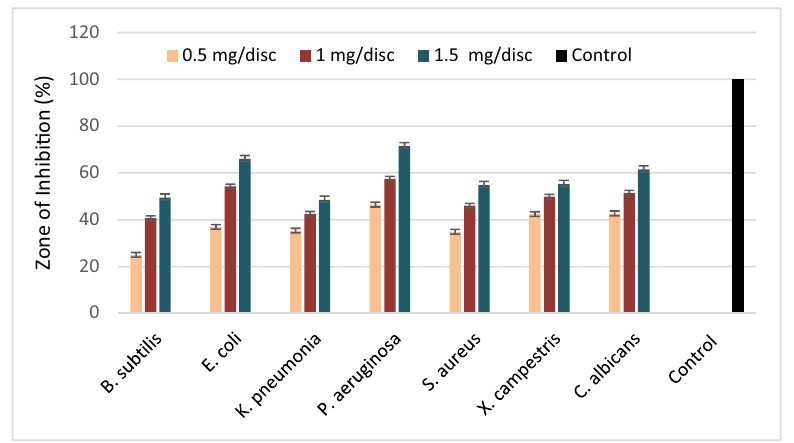
Figure 8: Antimicrobial potential of AgNPs, with standard deviation, against tested microbial